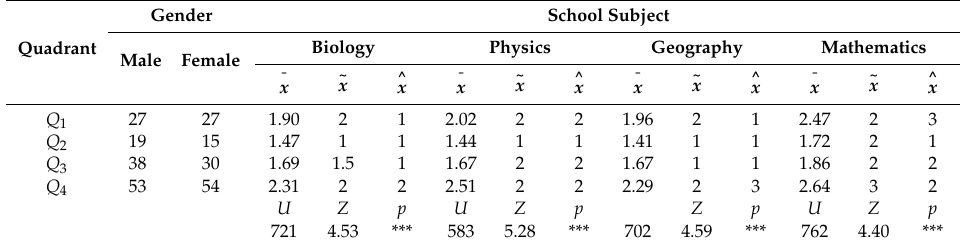
Table 2. School marks of respondents achieved in di ff erent subjects.